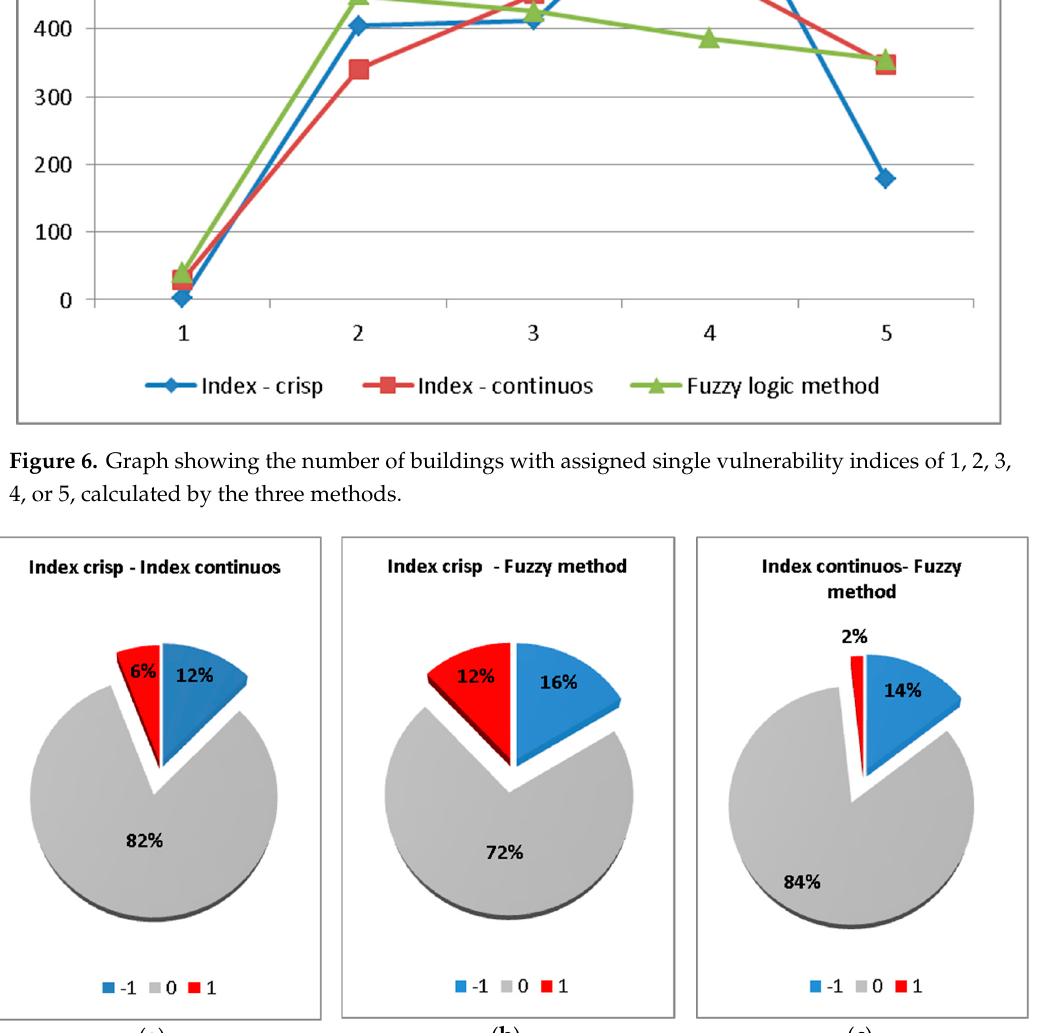
Figure 7. Graphs showing how many buildings have differences in their single vulnerability indexes calculated by the two methods (a blue colour represents a -1 score, red is a 1 score, and grey means no difference): ( a ) Index method with crisp ranking—Index method with continuous ranking; ( b ) Index method with crisp ranking—Fuzzy logic method; and ( c ) the Index method with continuous ranking— Fuzzy logic method.